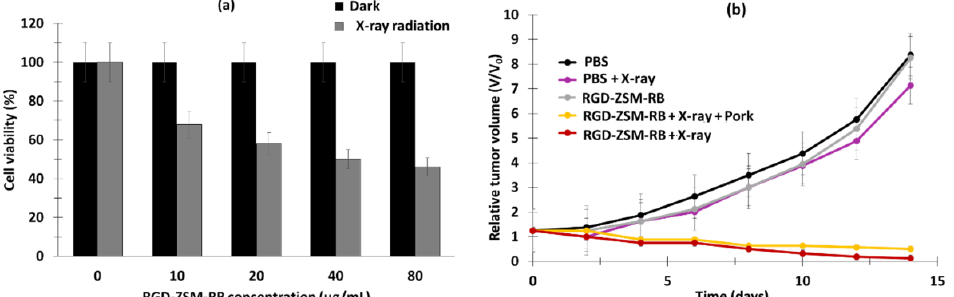
Figure 39. ( a ) In vitro evaluation of X-PDT. Cell viability of U87MG cells incubated with different concentrations of RGD-ZSM-RB with or without X-ray irradiation (50 kV, 1 Gy, 10 min). ( b ) In vivo evaluation of X-PDT. Relative tumor volume obtained from mice under different treatment conditions (X-ray irradiation (1.0 Gy, RGD-ZSM-RB: 20 mg/kg) at different times (1, 2, 4, 6, 8 and 12 h) after injection). Adapted from Sun et al. [106].